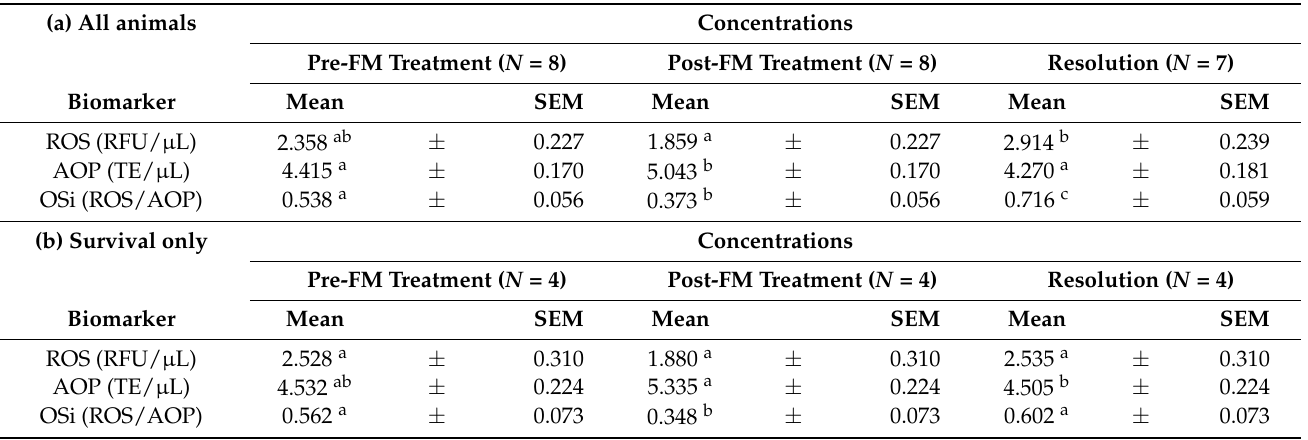
Table 1. Blood biomarkers of oxidant status over the course of systemic coliform mastitis with FM treatment in Holstein cows.